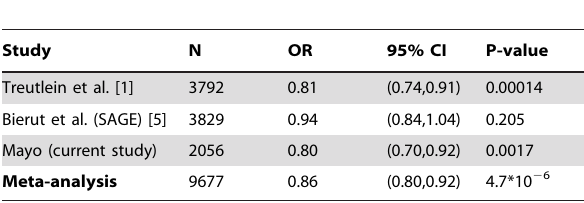
Table 3. Meta-analysis of the association of alcohol dependence with ADH1C SNP